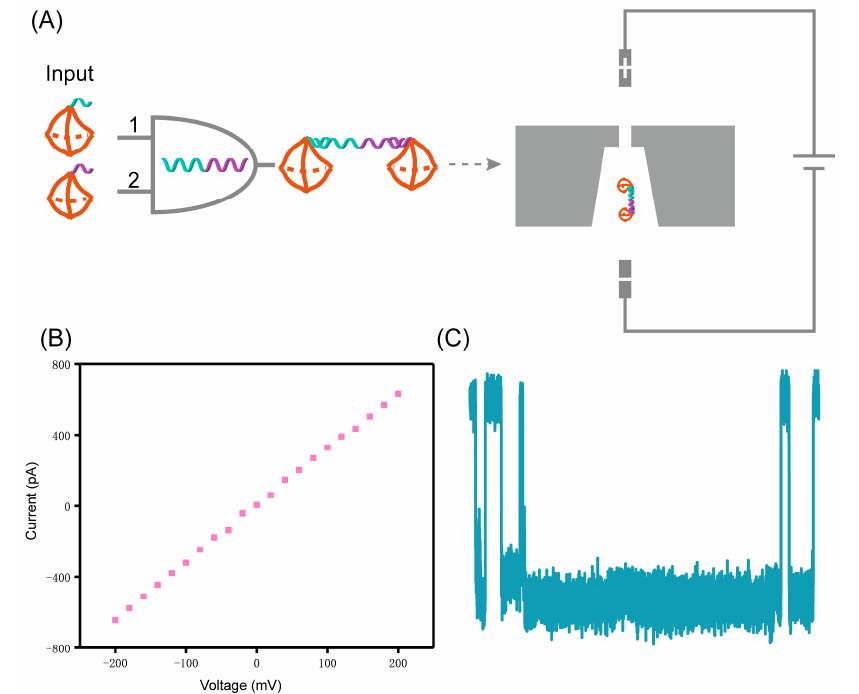
Figure 1. ( A ) Schematic illustration of the AND gate for marker molecules of lung cancer. When Probe 1 and Probe 2 are provided as inputs at the same time, they form a double tetrahedral structure with the marker molecules, causing a long blockage when translocated through the solid-state nanopore under an external voltage; ( B ) I-V characterization curve of the SiNx nanopore with a diameter about 3.5 nm in the range ± 200 mV; ( C ) The signals after the AND operation.